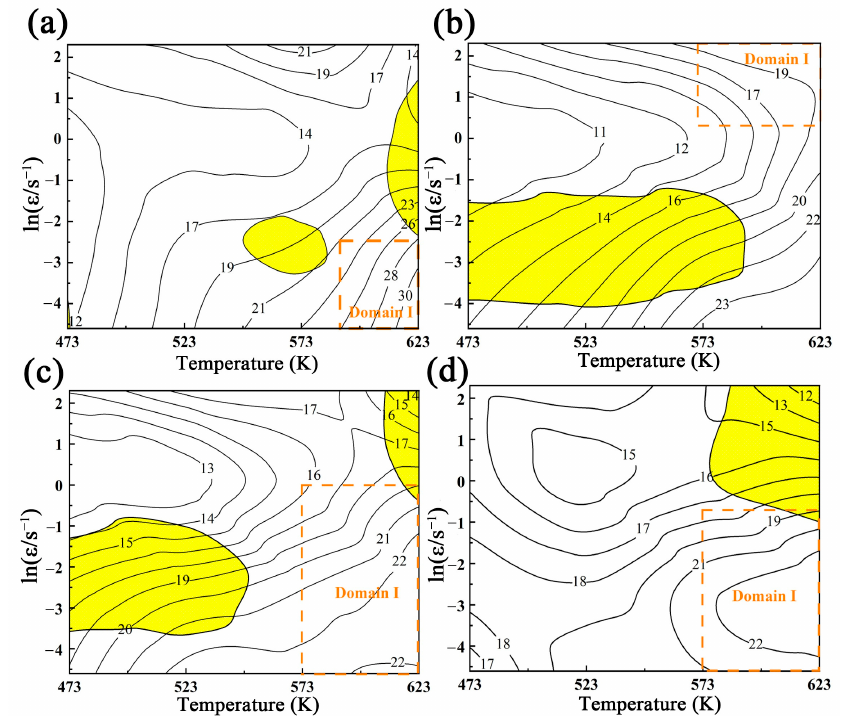
Figure 8. The processing maps of Mg-3Bi alloy at different strains: ( a ) ε = 0.1, ( b ) ε = 0.3, ( c ) ε = 0.5, ( d ) ε = 0.8.